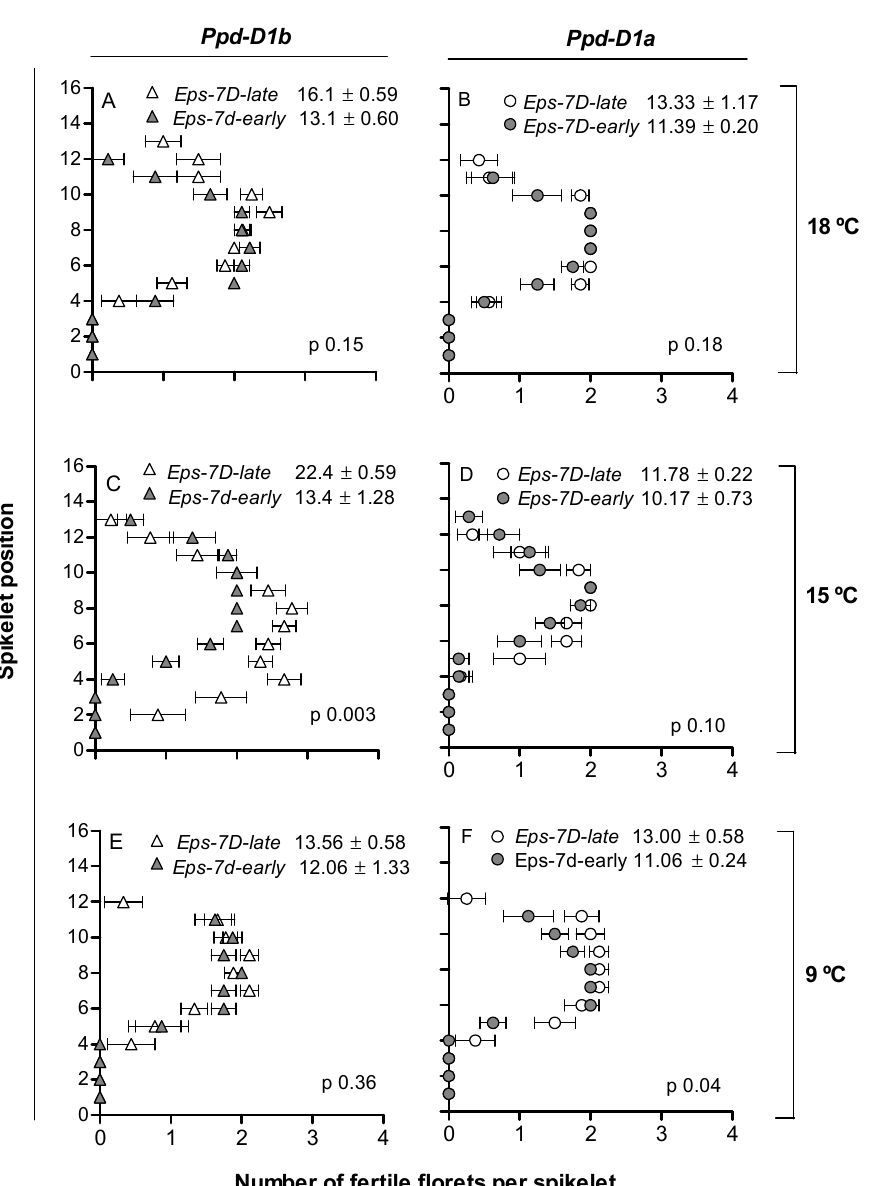
Figure 5. Number of fertile florets at anthesis in each spikelet along the spike (spikelet 1 is the first, most basal, spikelet) for the lines carrying Eps-7D-late (open symbols) or -early (closed symbols) allele with Ppd-D1b (triangles, A , C , E ) or Ppd-D1a (circles, B , D , F ) alleles in the background under short day at three growing temperatures: 18 ( A , B ), 15 ( C , D ) and 9 ◦ C ( E , F ). Error bars indicate the SEM. The inset of each panel consists of the fertile florets per spike and the p -value indicates the level of significance of the difference between Eps-7D-late and -early lines within each condition ( Ppd-D1 in the background and growing temperature).